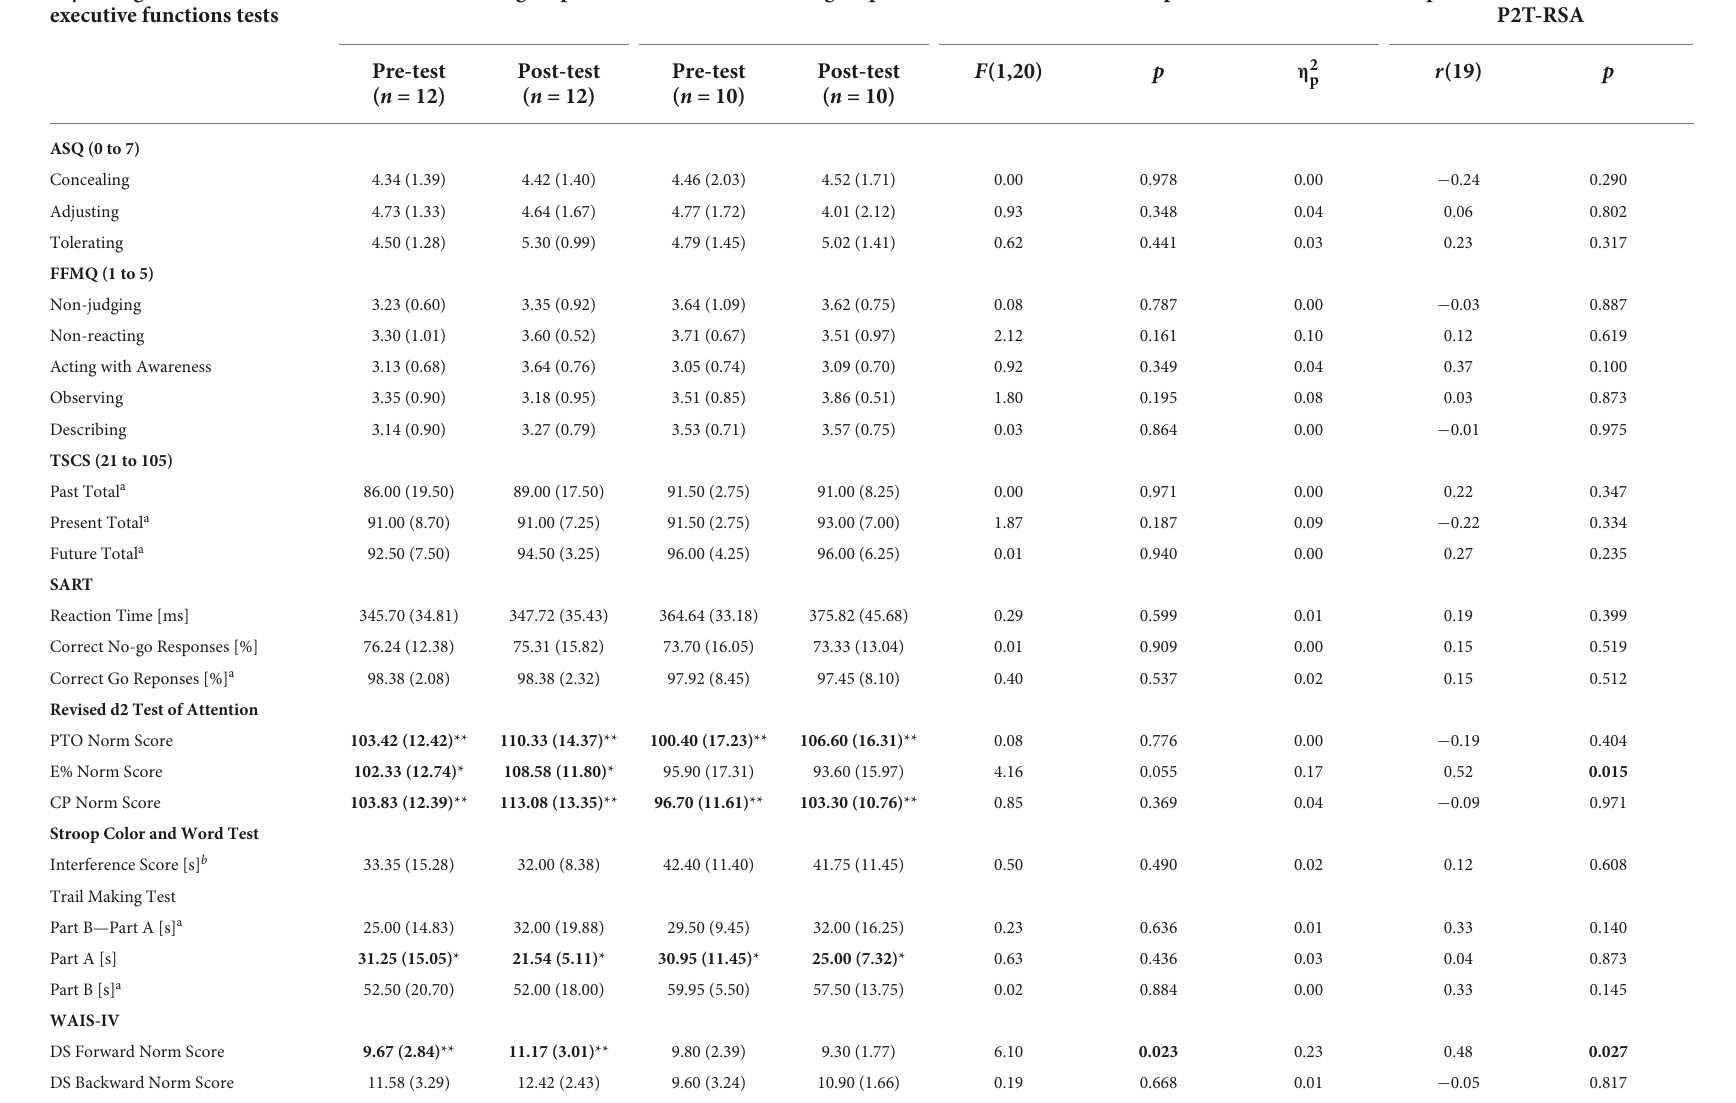
TABLE 4 Psychological scales and executive